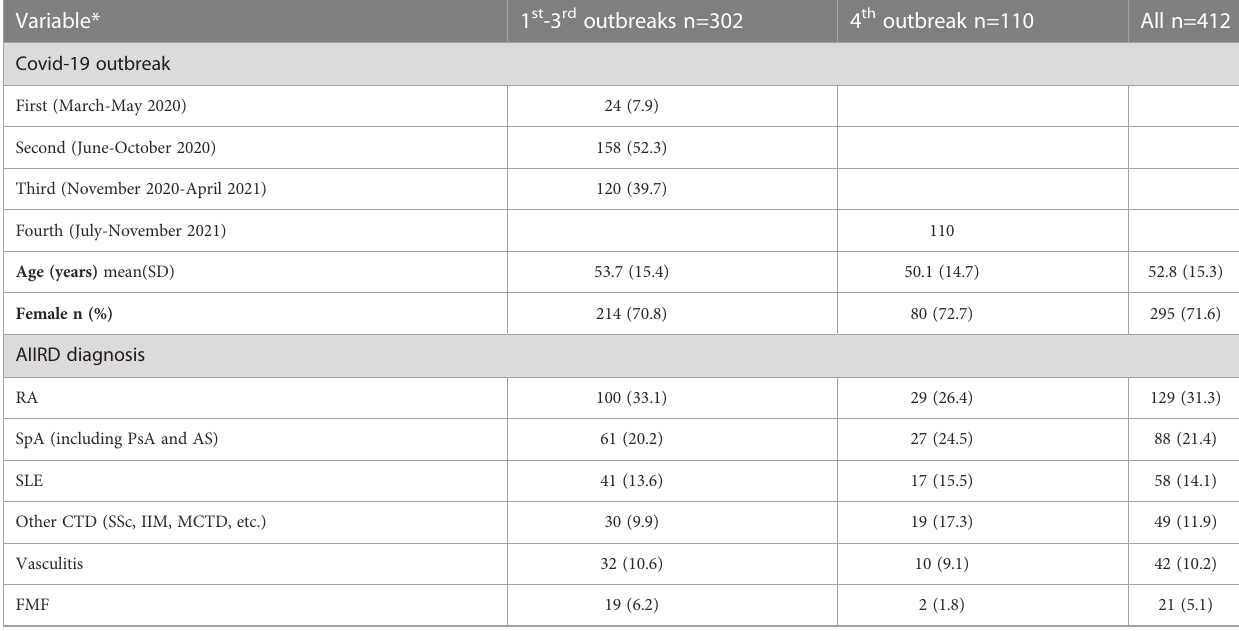
TABLE 1 Demographic and clinical characteristics of AIIRD patients in the Israeli Rheumatologic COVID-19 registry.